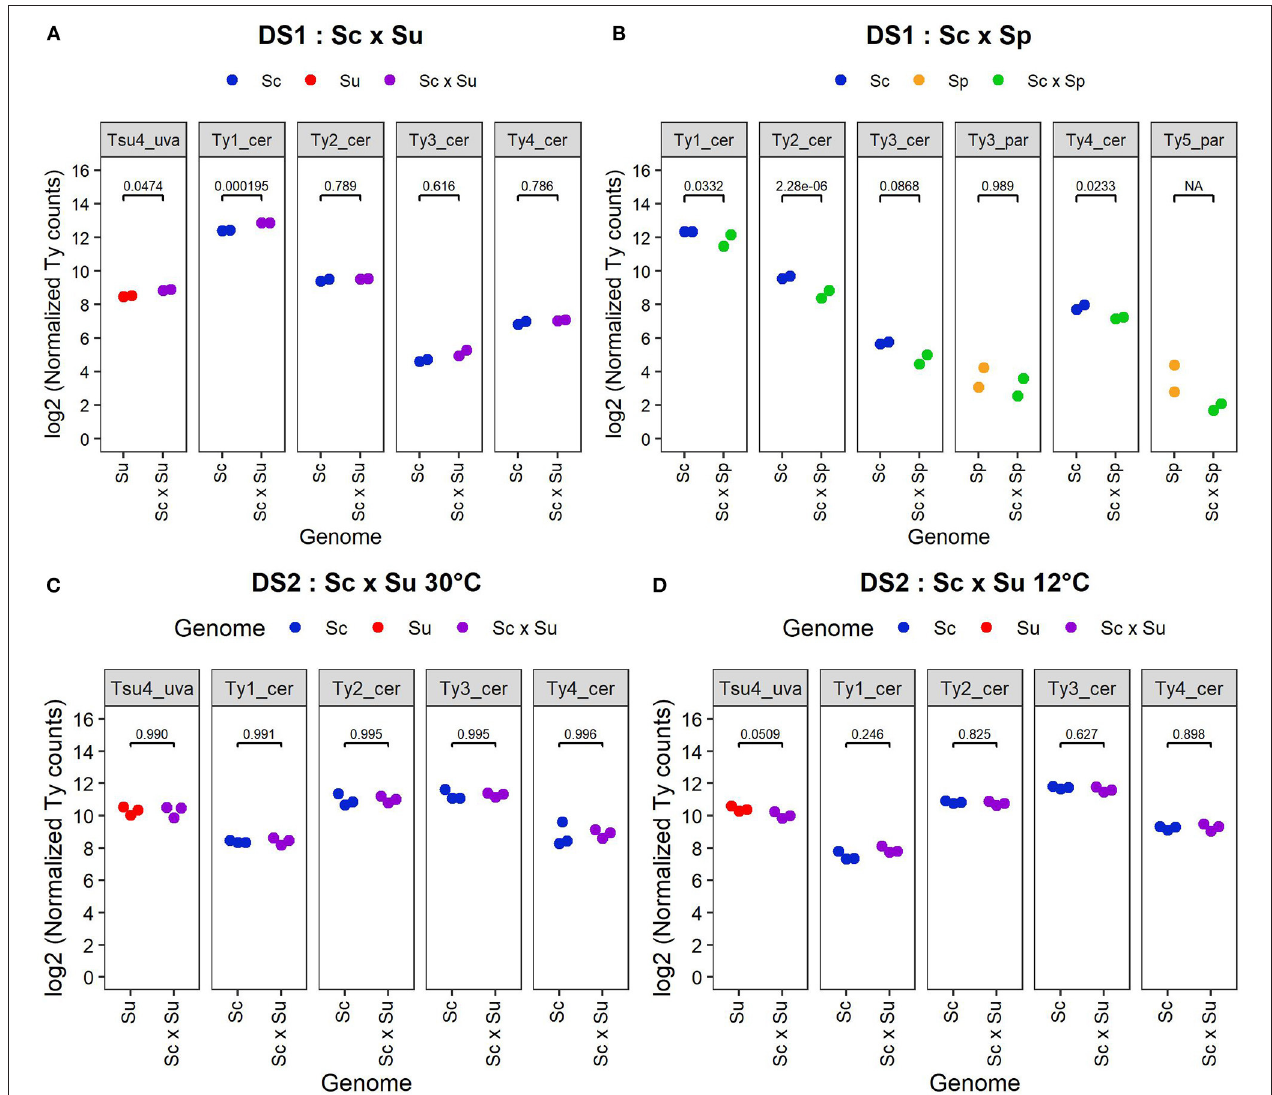
FIGURE 4 | Normalized read counts from DS1 (A,B) and DS2 (C,D) . Log 2 of normalized read counts for each active Ty family are shown for S. cerevisiae (YHL068) parent, S. cerevisiae x S. uvarum hybrid and S. uvarum (CBS 7001) parent from DS1 (A) ; for S. cerevisiae (YHL068) parent, S. cerevisiae x S. paradoxus hybrid and S. paradoxus (CBS432) parent from DS1 (B) ; for S. cerevisiae (YPS128) parent, S. cerevisiae x S. uvarum hybrid and S. uvarum (UWOPS99-807.1.1) parent from DS2 grown at 30 ◦ C (C) and 12 ◦ C (D) . Normalized counts correspond to pseudo normalized counts since the normalized values have been increased by 1 before the log transformation. Note that unlike other Ty families, the analysis of Ty1_cer in Sc x Sp hybrids was done with the exclusion of its GAG